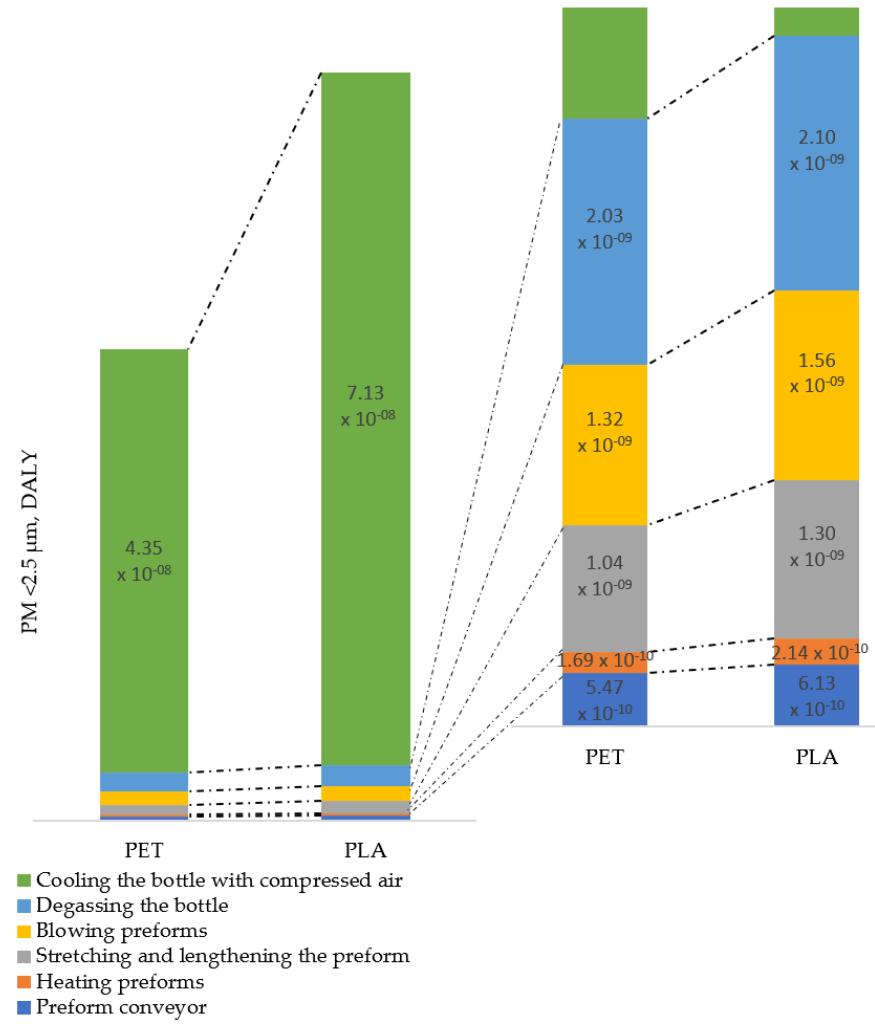
Figure 14. PM < 2.5 μm dust emissions to air and its impact on human health. Bearing in mind the negative impact of airborne dust, special attention was paid to fine dust fractions and their impact on human health. To date, no threshold has been set below which PM10 and PM2.5 particulate matter would not pose a risk. The analyses show that the highest concentration levels in the entire PET bottle shaping process were determined for PM10 particles, while the lowest concentration levels were determined for coarse particles in the PM2.5–10 range (Figure 15). In the case of the process of shaping PLA bottles, lower concentration values of all the technological operations were noted. Both fine and coarse particles were characterized by lower concentration parameters, which shows that the process of shaping biodegradable bottles is more environmentally